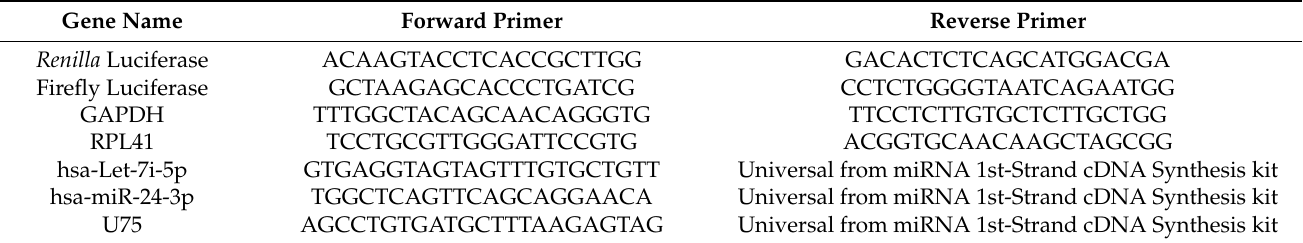
Figure 8. Levels of mRNAs for translation initiation factors cells assayed by microarrays (results available in ArrayExpress) normalized to cell numbers used for isolation of RNA. Each panel shows differences in a specific EIF group. The results are presented as mean values ± SD of three microarray experiments normalized to the number of cells, * denotes the statistical significance of the difference between HCT116 and Me45 cells ( p < 0.05). Table 3. Real Time PCR primers.